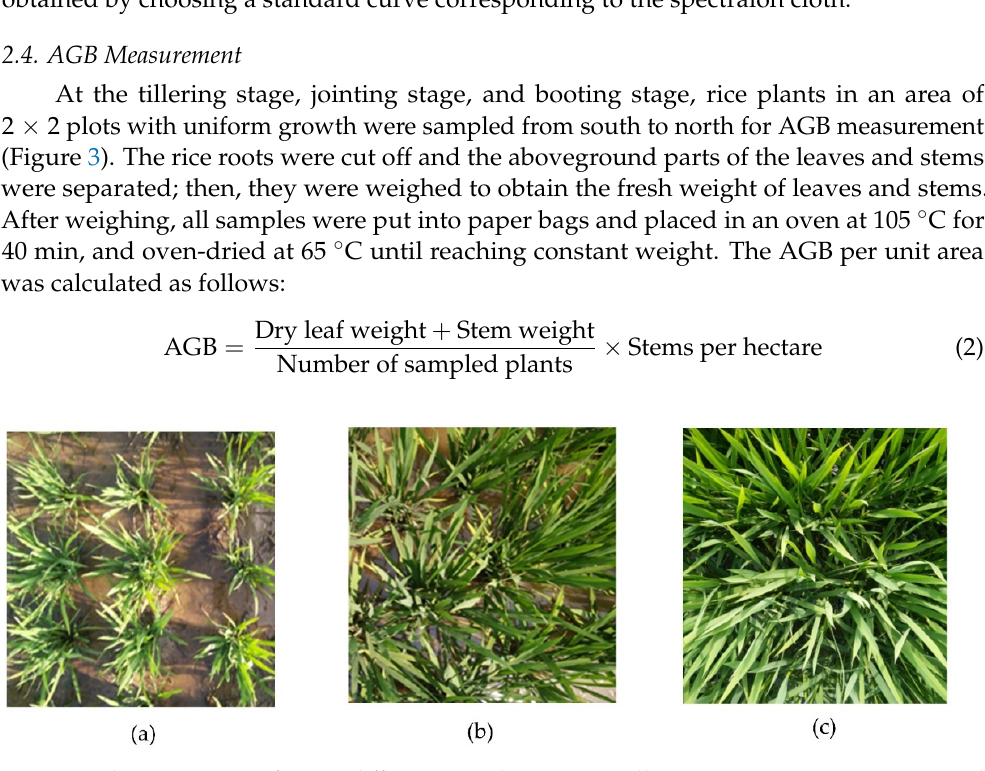
Figure 2. UAV image acquisition: ( a ) UAV platform, ( b ) Multispectral Rikola Camera, and ( c ) UAV flight experiments.